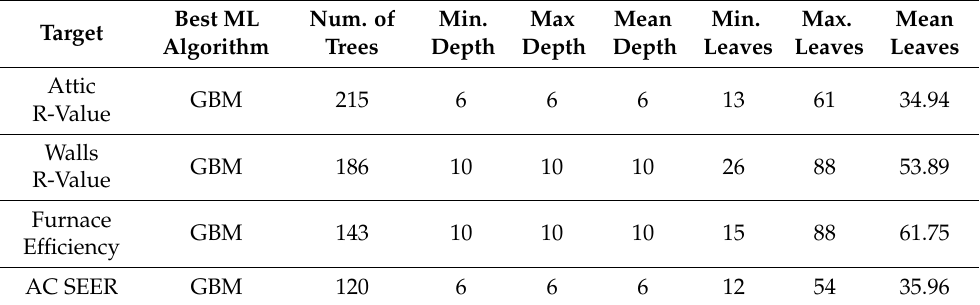
Table 12. Model hyperparameters for all targets without using thermostat-derived information. Best ML Num. of Target Algorithm